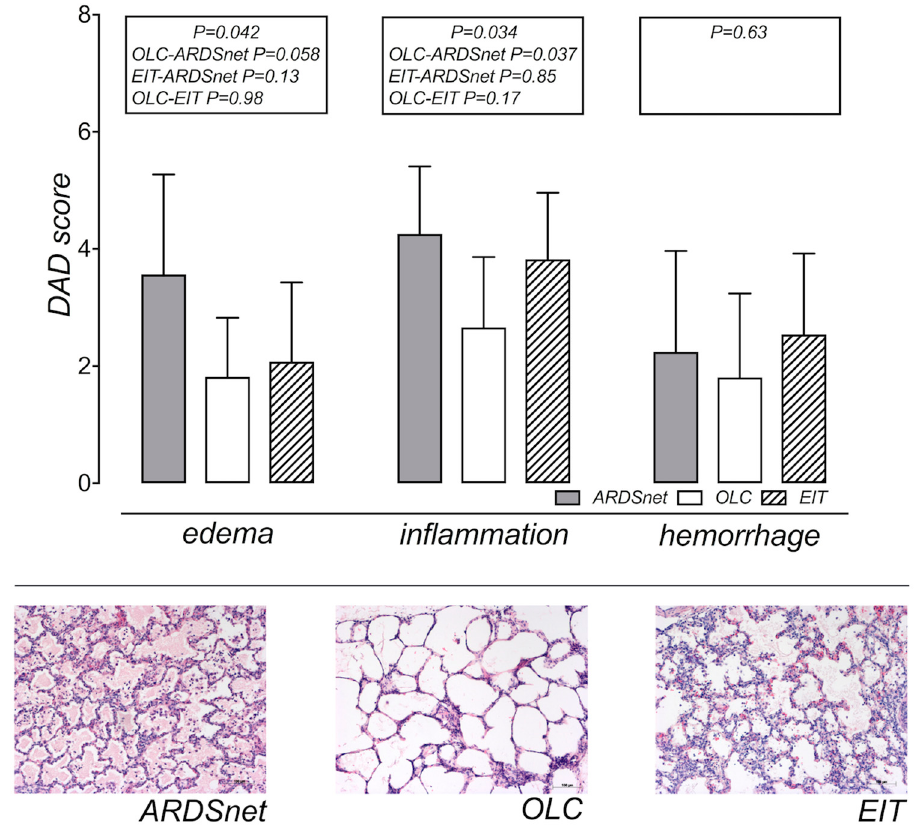
Figure 3. Histological results: diffuse alveolar damage score and histologic samples. The diffuse alveolar damage (DAD) sub-scores (0–12 with increasing severity) are shown for the criteria intra-alveolar edema, inflammation, and hemorrhage as grand mean over all regions for each ventilation group. The bar plots indicate means and standard deviations. Parametric testing was considered appropriate and was done with ANOVA, being significant for inflammation and edema ( p < 0.05). In Sidak’s post-hoc test OLC vs. ARDSnet differed significantly for inflammation ( p = 0.037) with a tendency to lower scores for edema ( p = 0.058). Hemorrhage did not differ between groups ( p = 0.63). Representative histology samples for the ARDSnet, OLC, and EIT group are shown in the lower panel (100x magnification).